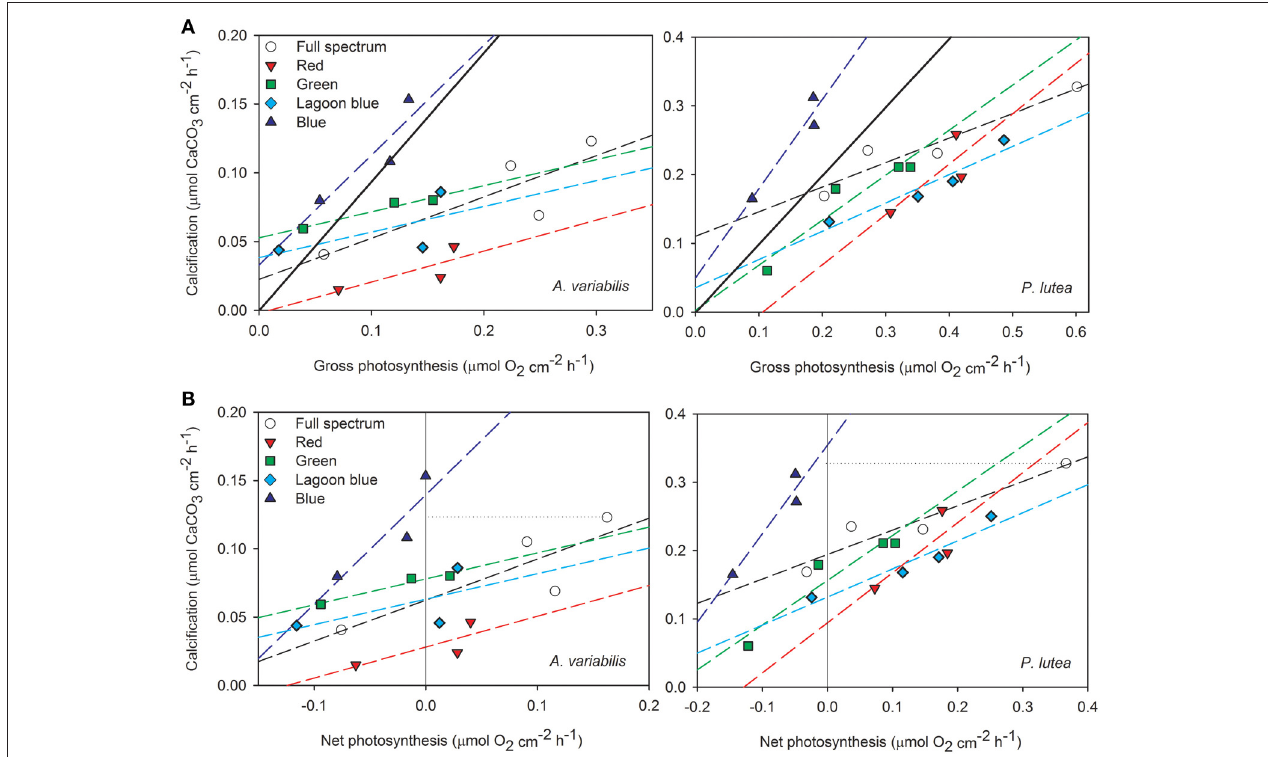
FIGURE 4 | Rates of calcification are plotted against (A) gross photosynthesis and (B) net photosynthesis of A. variabilis and P. lutea in the four spectral ranges, including the full spectrum control. The diagonal full line marks the 1:1 ratio between the processes and the horizontal dotted line is drawn from the highest calcification rate under full spectrum for comparison with blue